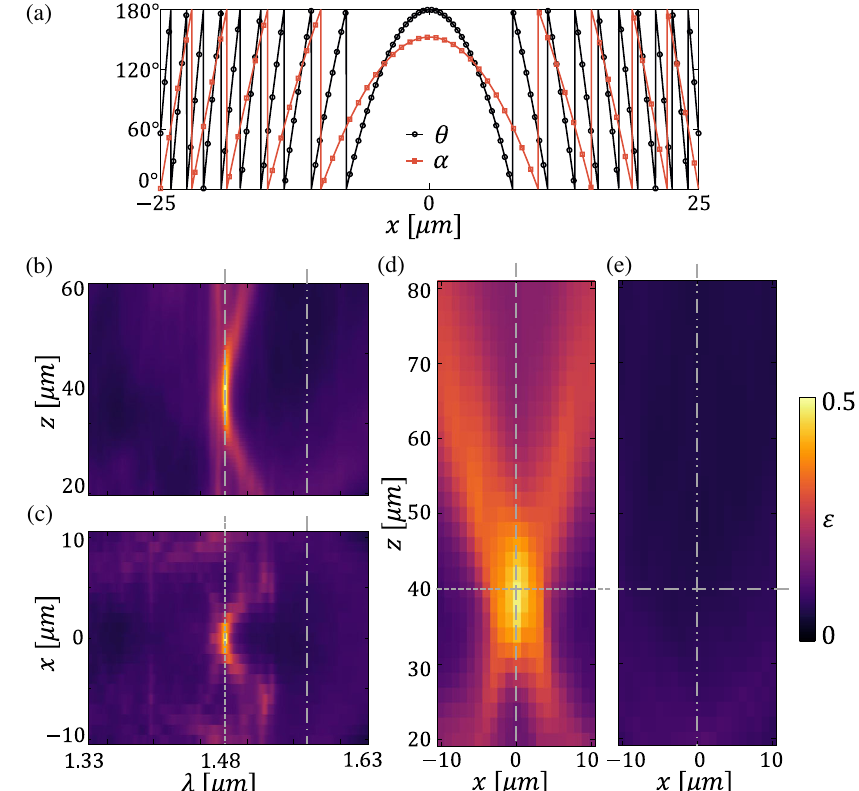
FIG. 8. Thermal metasurface focusing narrow-band RCP light emission. (a) Angular parameters of the thermal metasurface producing focused thermal emission. (b) RCP emission map as a function of the wavelength and position z along the optical axis ( x ¼ 0 ). (c) RCP emission map as a function of the wavelength and position x at the focal plane ( z ¼ 40 μ m). (d),(e) Profile of emitted light near the focal spot of the device for the band-edge wavelength (d) and nonresonant wavelength